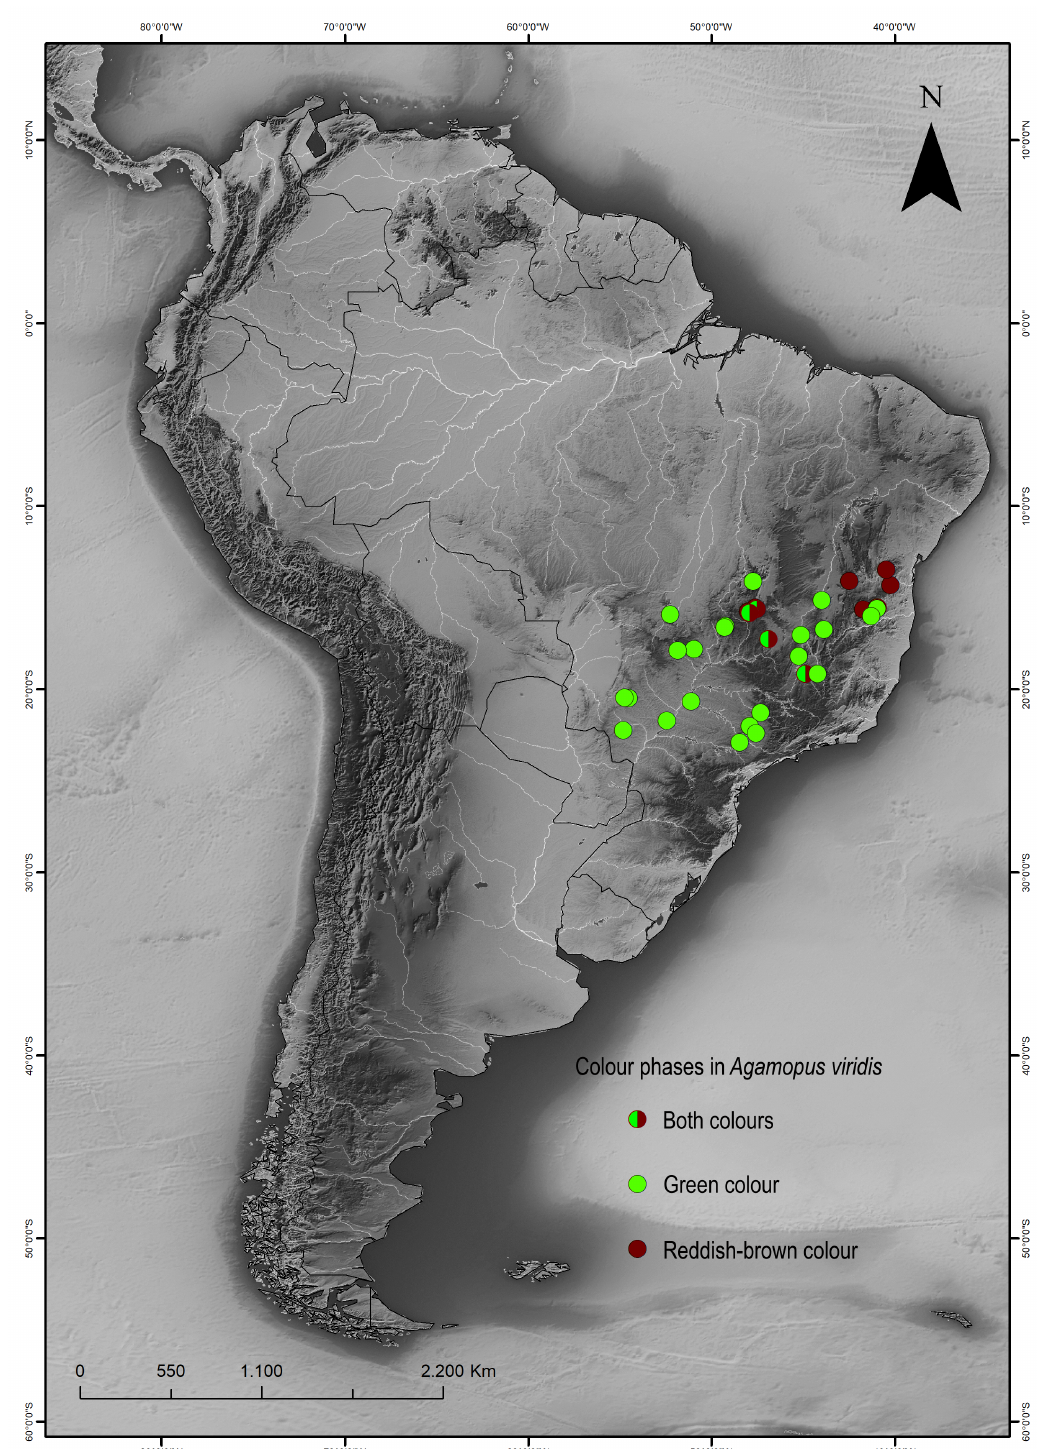
Fig. 10. Geographical distribution map of two colour phases of the pronotum of Agamopus viridis Boucomont, 1928. Green circles represent the specimens with the pronotum green metallic; the reddish- brown circles represent the specimens with a reddish-brown pronotum; the green/reddish-brown divided circles represent the sites where both colour phases were